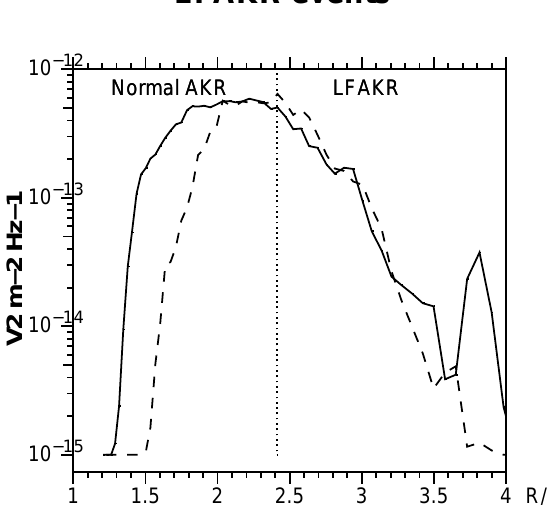
Fig. 2. Same as Fig. 1 but plotted as a function of AKR source radial distance.